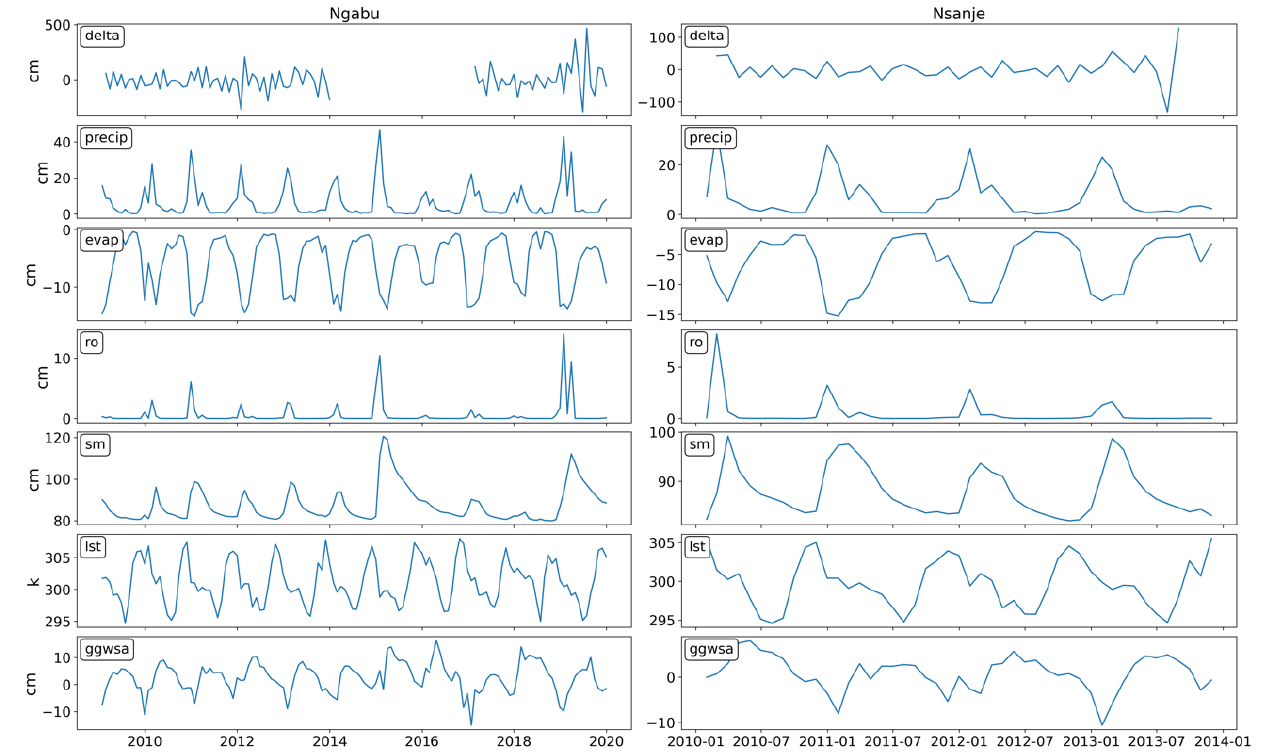
Figure 6. Time series of the various hydroclimatic inputs vs. groundwater level changes for each borehole. Delta = Monthly groundwater level change, precip = total monthly precipitation, evap = total monthly evapotranspiration, ro = total monthly runoff, sm = average monthly soil moisture, lst = average monthly land surface temperature, ggwsa = monthly GRACE groundwater storage change.